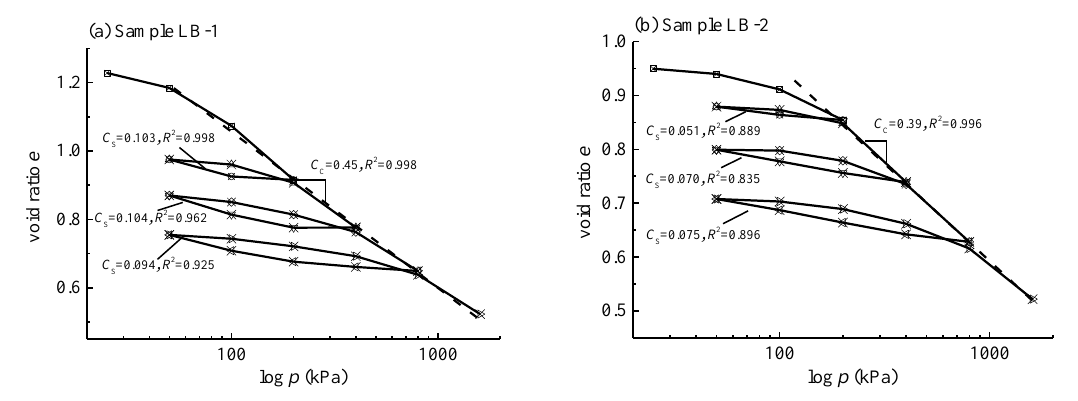
Figure 7. e -log p (vertical load) curves for samples LB-1 and LB-2.